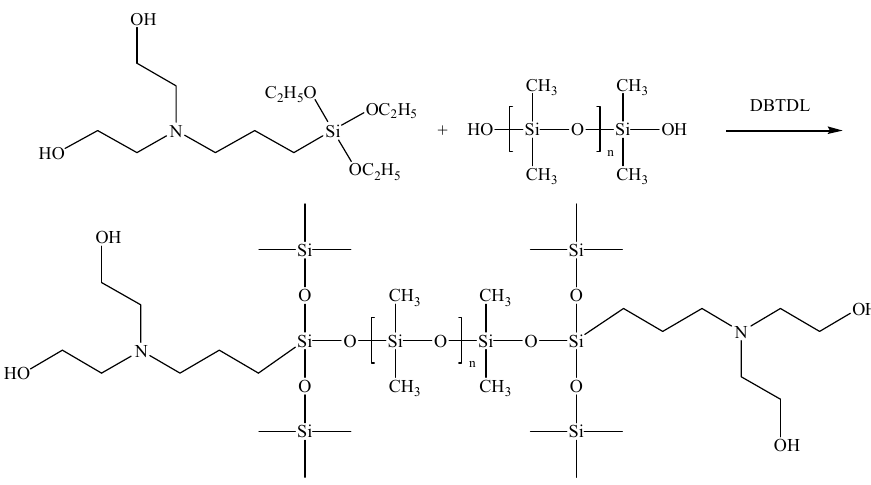
Figure 3. The cross-linking reaction principle of epoxy modified silicone coating.